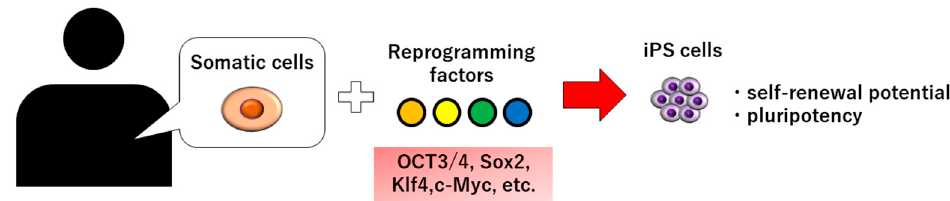
Figure 1. Schematic illustration of iPS cell production.